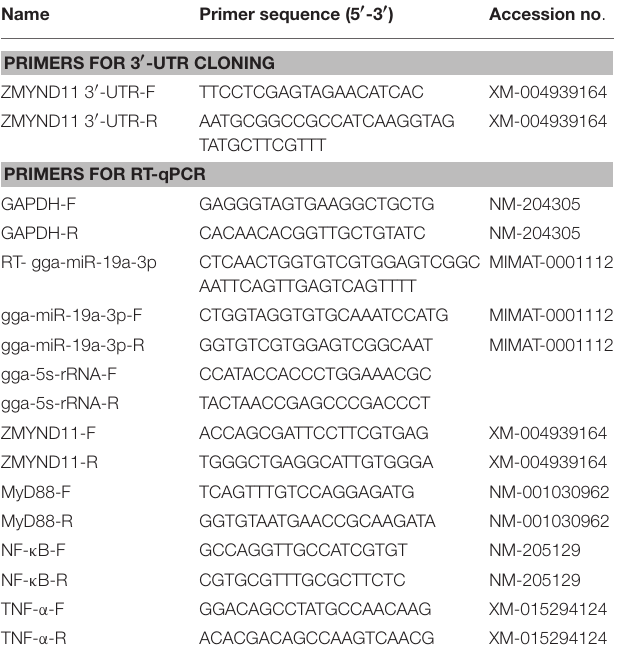
TABLE 1 | Sequences of DNA primers.